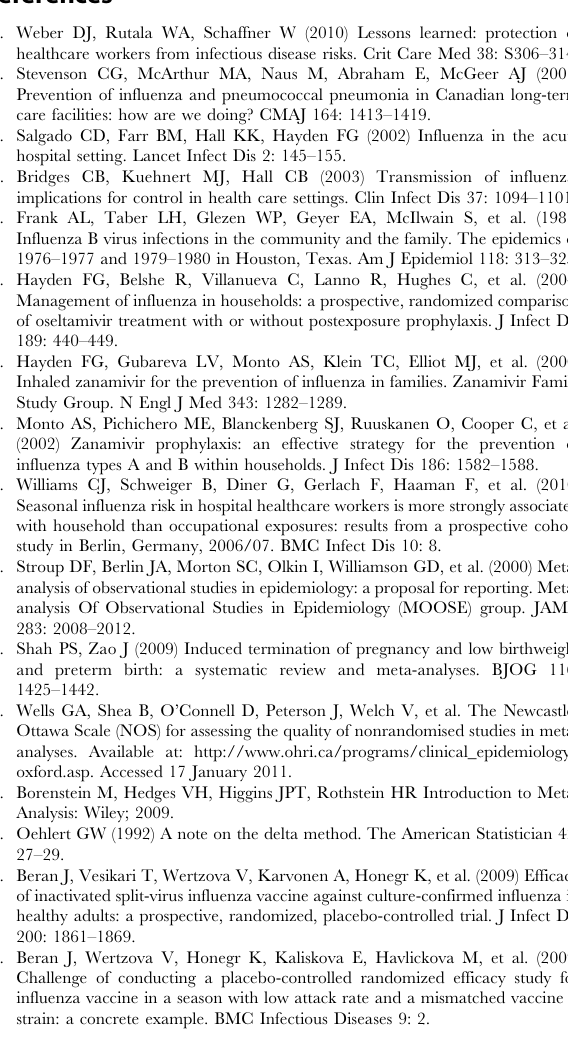
Table S2 Baseline characteristics of studies of rates of influenza in community-dwelling, working age adults assessing all infections or symptomatic influenza infec- tion only. Table S3 Baseline characteristics of studies of rates of influenza infection in healthcare workers assessing all infections or symptomatic influenza only. Table S4 Risk of bias of included